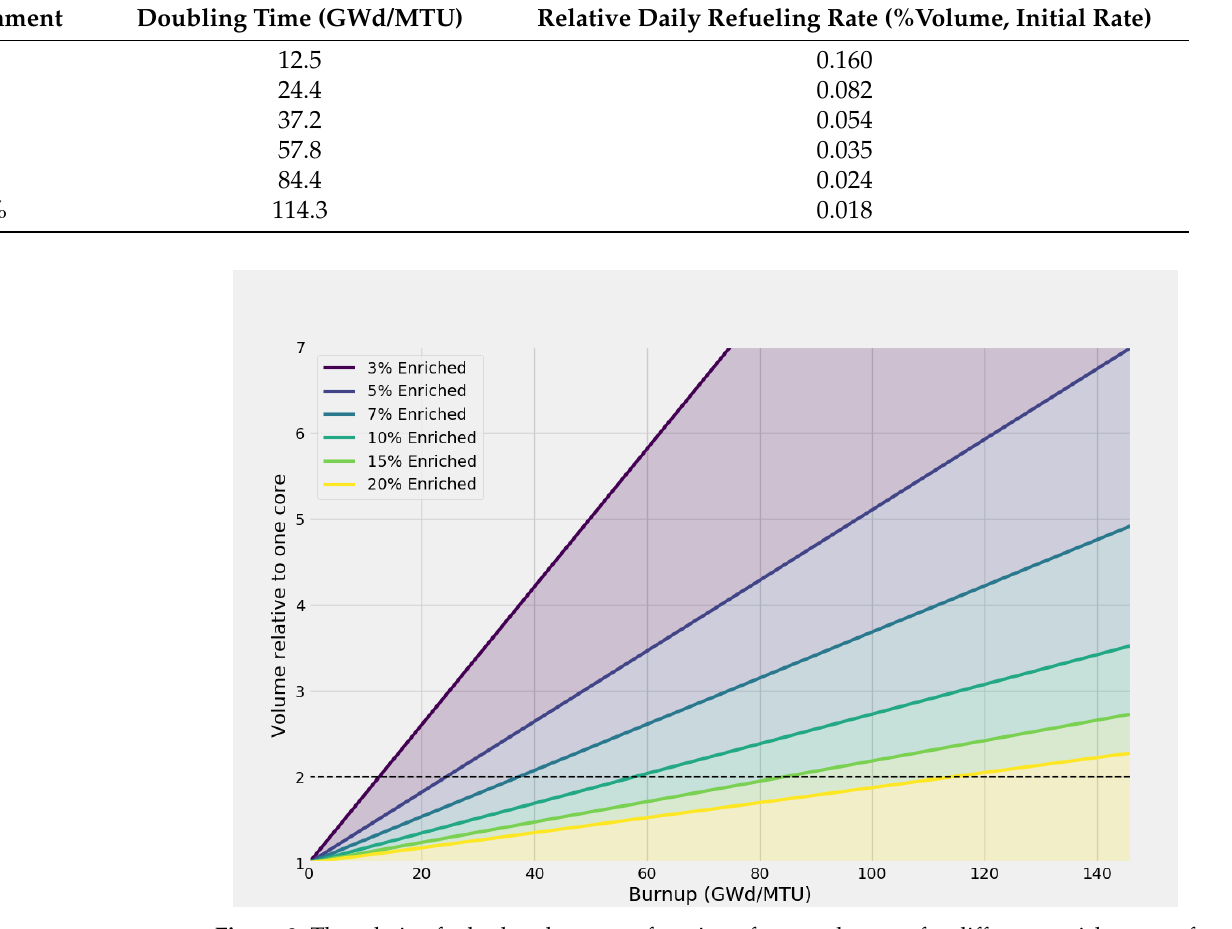
Figure 3. The relative fuel salt volume as a function of reactor burnup for different enrichments of refuel salt. The dashed line indicates when there is enough excess fuel to start another